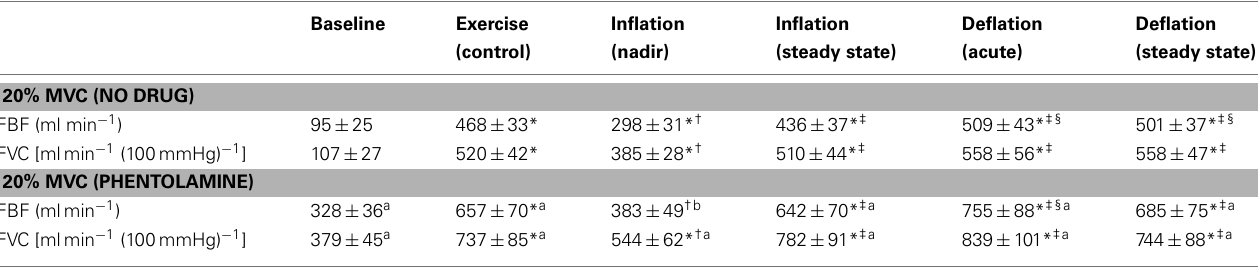
Values are means ± SE. FBF, forearm blood flow; FVC, forearm vascular conductance; MVC, maximal voluntary contraction. *P < 0.01 vs. baseline; † P < 0.001 vs.